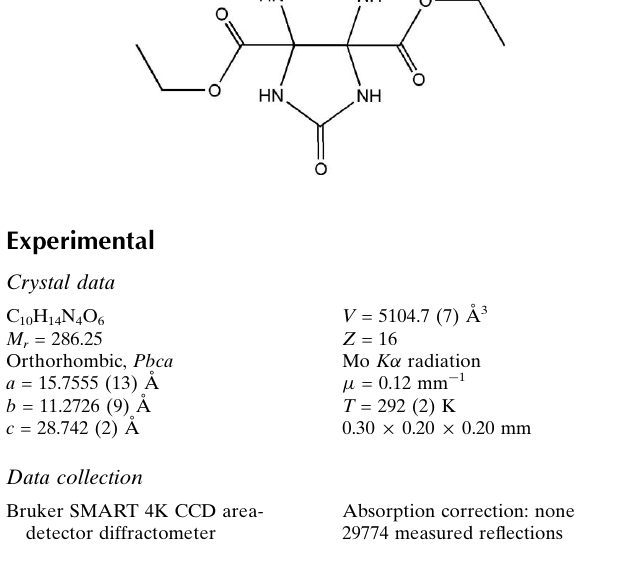
Bruker SMART 4K CCD area- detector diffractometer